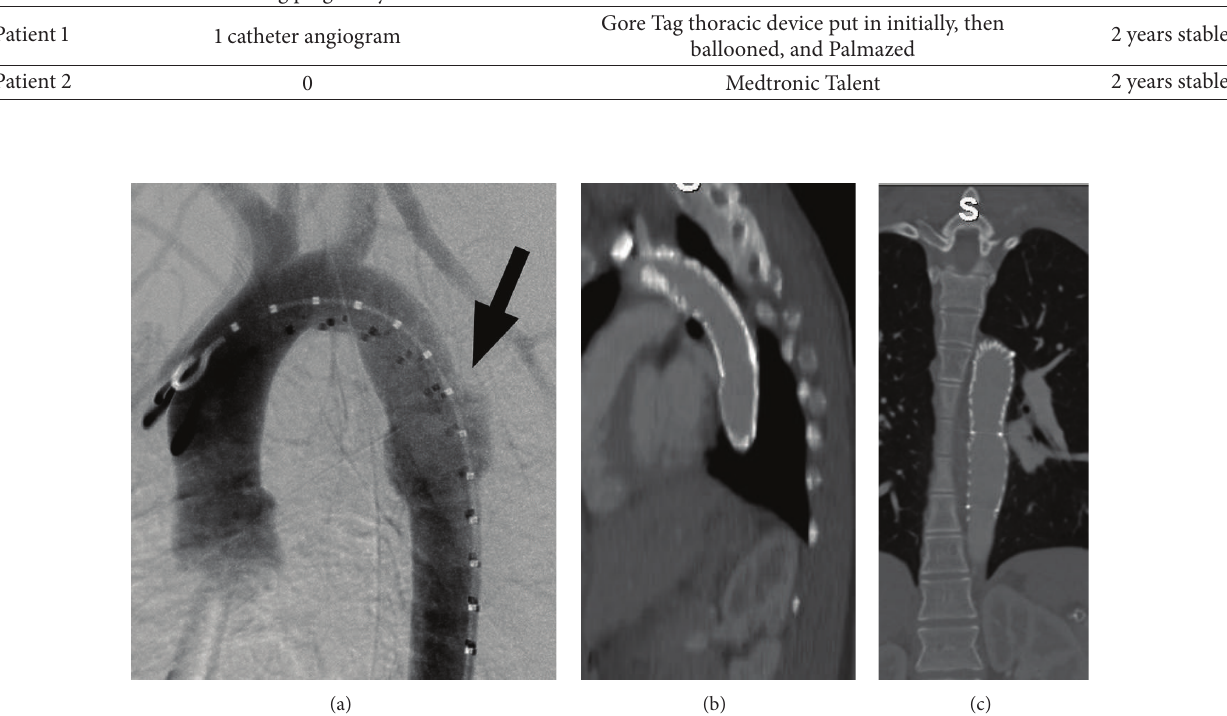
Figure 1: (a) Transection of descending thoracic aorta in 19-year-old multitrauma victim. (b) The stent graft lies in satisfactory position and